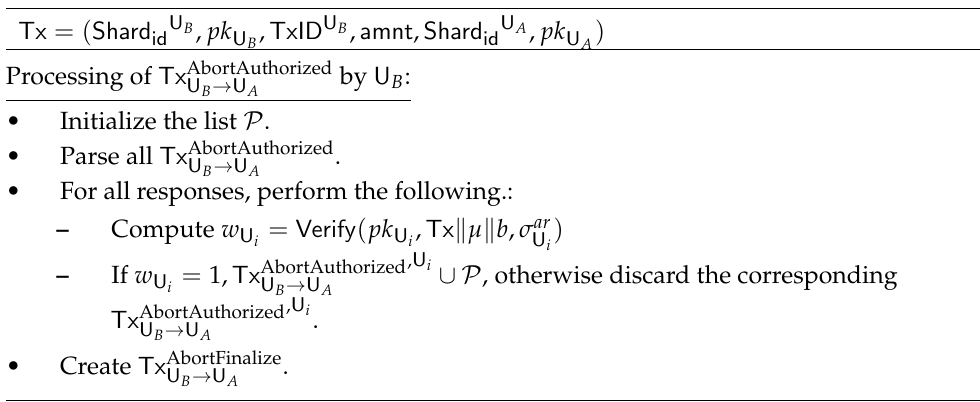
by a Dandelion node U i . U B → U A